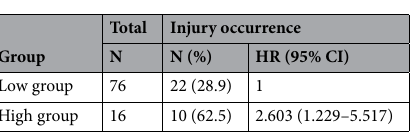
Table 2. Results of the Cox proportional hazards model. HR hazard ratio, CI confidence